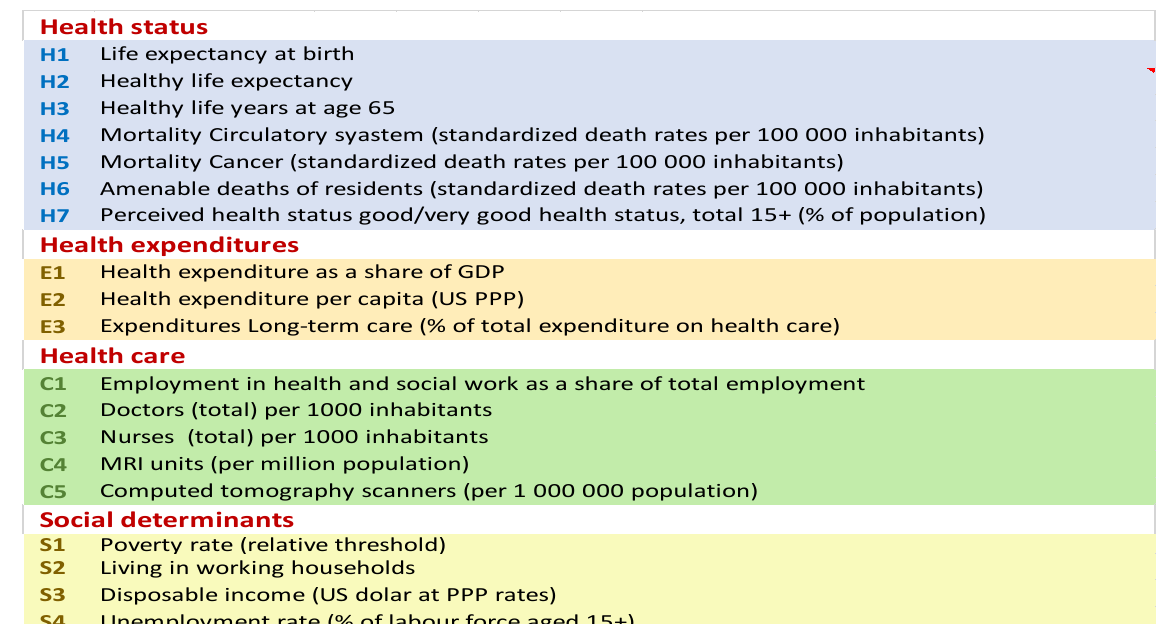
Table 1. Indicators (2016 or latest available